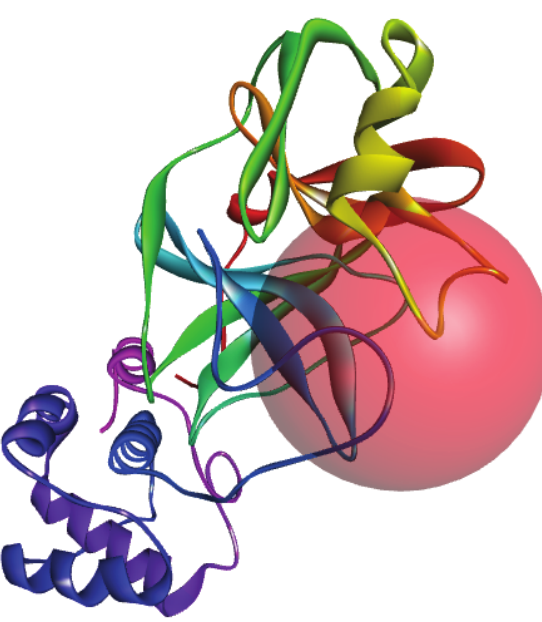
Figure 1 : Binding pocket (red color balloon) of SARS-CoV-2’s main